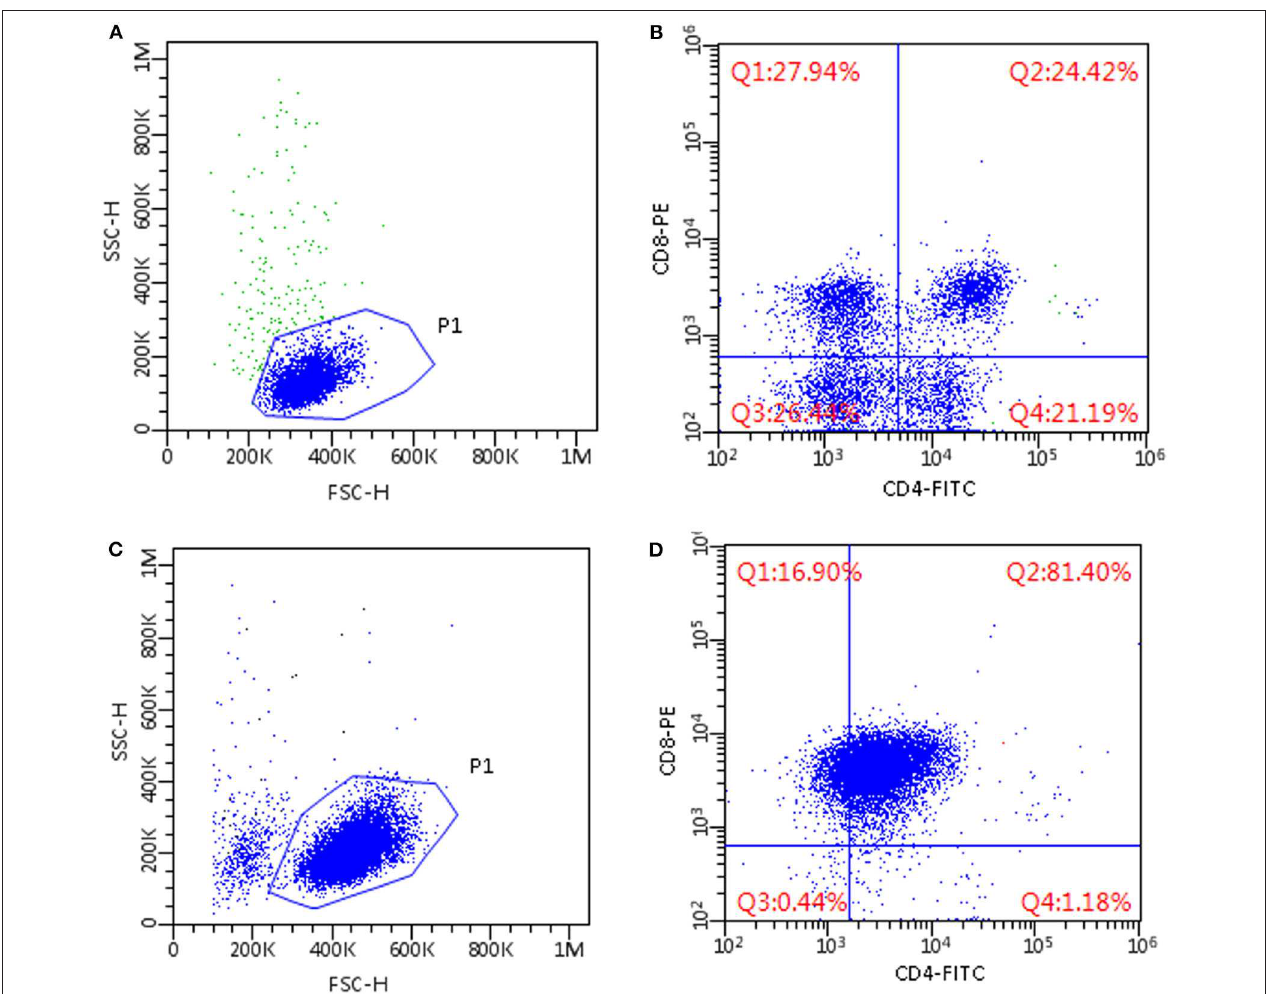
FIGURE 1 | Flow cytometric scattergrams of mediastinal masses in two cats. (A,C) Morphological scattergrams, a gate (P1) was set to exclude debris and disrupted cells. (B,D) Only P1 cells are shown, based on CD4 and CD8 staining. Fluorescence discriminators were set based on the level of fluorescence of unstained cells from the same sample. (A,B) Non-lymphomatous lesion; cells are small-sized and composed of mixed subpopulations of T-cells, including CD4 + CD8 + double-positive cells ( B , upper right quadrant). (C,D) CD4 + CD8 + double positive T-cell lymphoma; cells are medium sized and a dominant population of CD4 + CD8 + double positive cells is present ( D , upper right